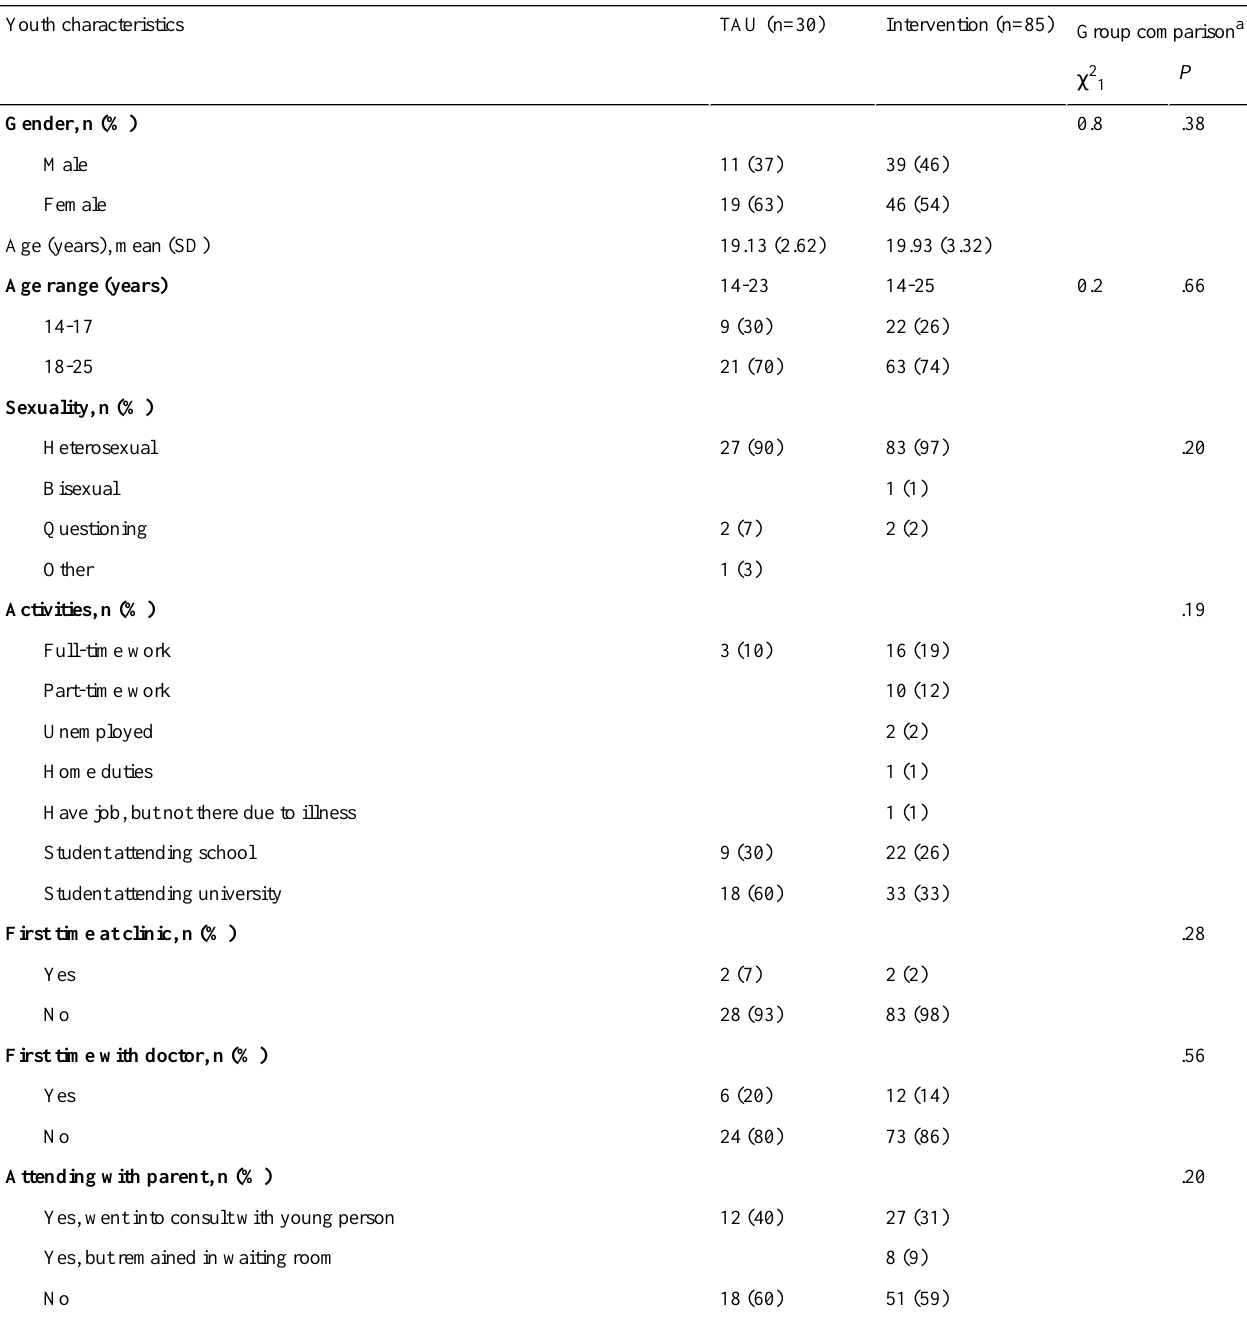
Table 4. Characteristics of youth participants in the treatment-as-usual (TAU) (n=30) and intervention (n=85) phase.